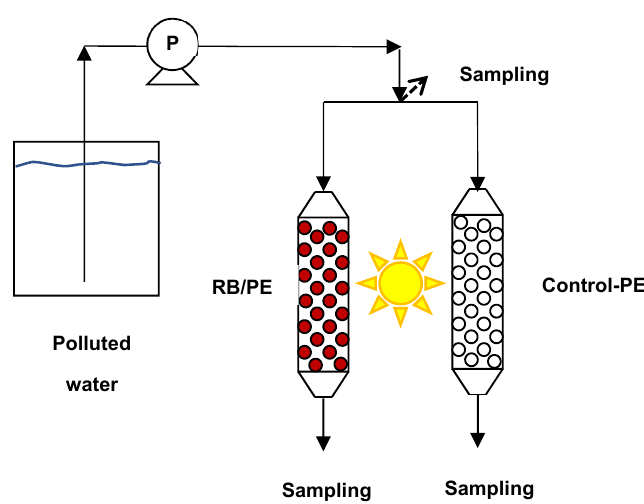
Figure 7. A scheme of continuous treatment of water polluted with pathogenic bacteria by immobilized RB ( left column ) and PE control beads ( right column ).